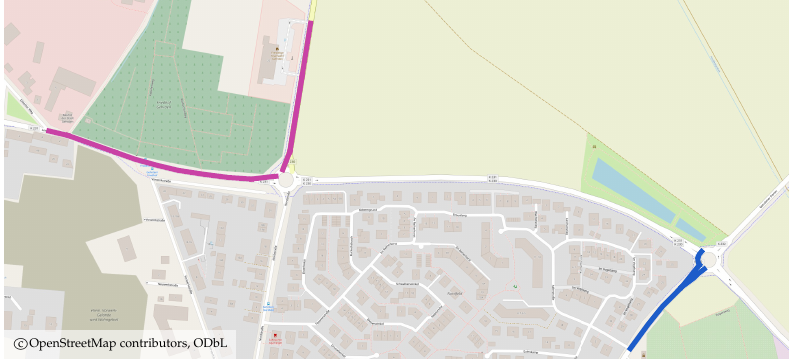
Figure 1. Example of structural dependencies in an urban road network observed near Gehrden,